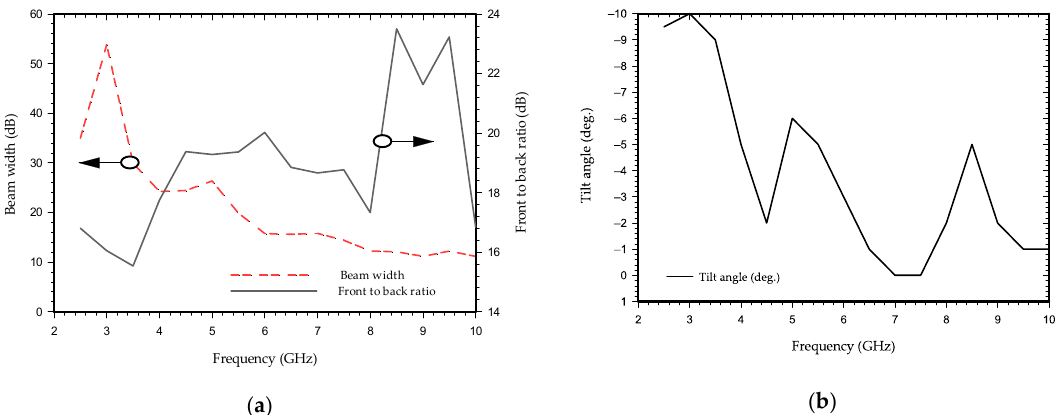
Figure 6. Simulated electric field, gain, and radiation pattern of the antenna: ( a ) electric field distribution at 4.5 GHz; ( b ) simulated realized gain of six and eight Vivaldi antennas array; ( c ) simulated radiation pattern at 4.5 GHz without phase shifter.